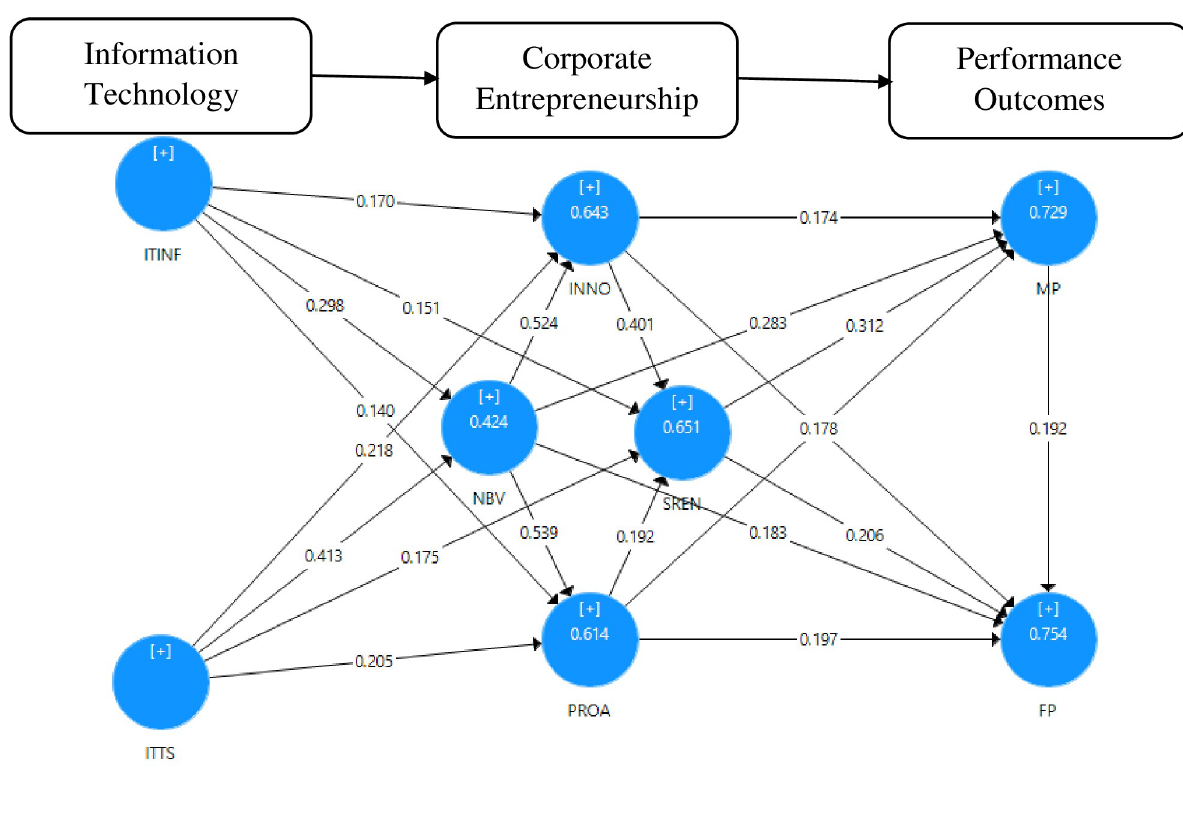
Fig 4. Structural model. ITINF = IT Infrastructure Flexibility, ITTS = IT Technical Skills, NBV = New Business Venturing, INNO = Innovation, PROA = Proactiveness, SREN = Self-renewal, FP = Financial Performance, MP = Market Performance.